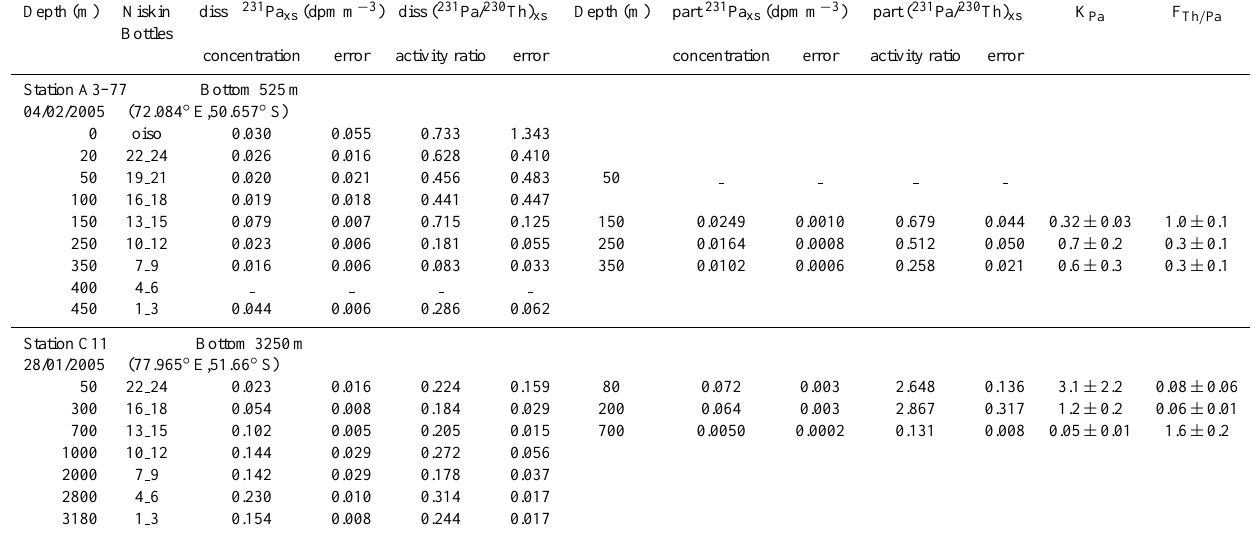
Table 3. Kerguelen plateau (A3–77) and off-plateau (C11) stations: dissolved and particulate 231 Pa xs concentrations in dpmm − 3 and corresponding 231 Pa xs / 230 Th xs activity ratios. Oiso (as Niskin number) stands here for the ship seawater intake (OISO program). For 230 Th and 231 Pa lithogenic contributions, please refer to Sect. 3 of the present text. Errors (2 σ) are further described in Sect. 2.4.3. All the activities that fall outside the sensible values (e.g. negative values) are